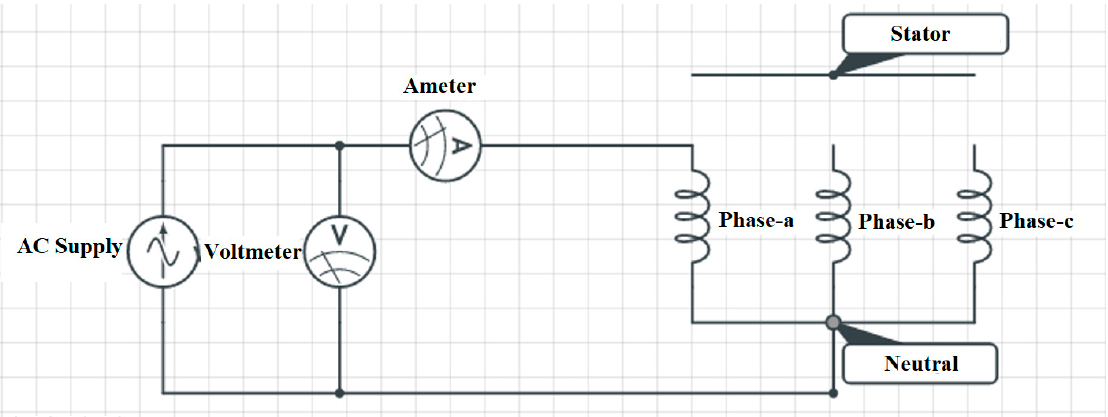
Figure 6. The circuit diagram of single-phase AC without rotor test.